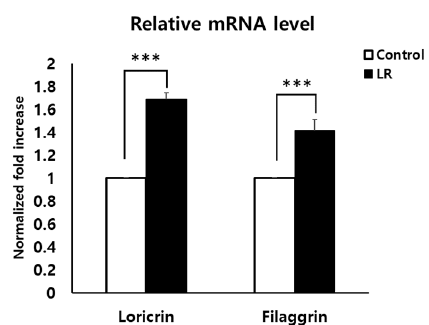
Figure 4. Increases of loricrin and filaggrin expression in LR-treated Keraskin TM . mRNA expressions of loricrin and filaggrin were measured by qRT-PCR. LR lysate was topically applied to Keraskin TM for 2 days. Results are expressed as mean ± SEM of independent three tests. *** p < 0.001 compared with PBS-treated control.